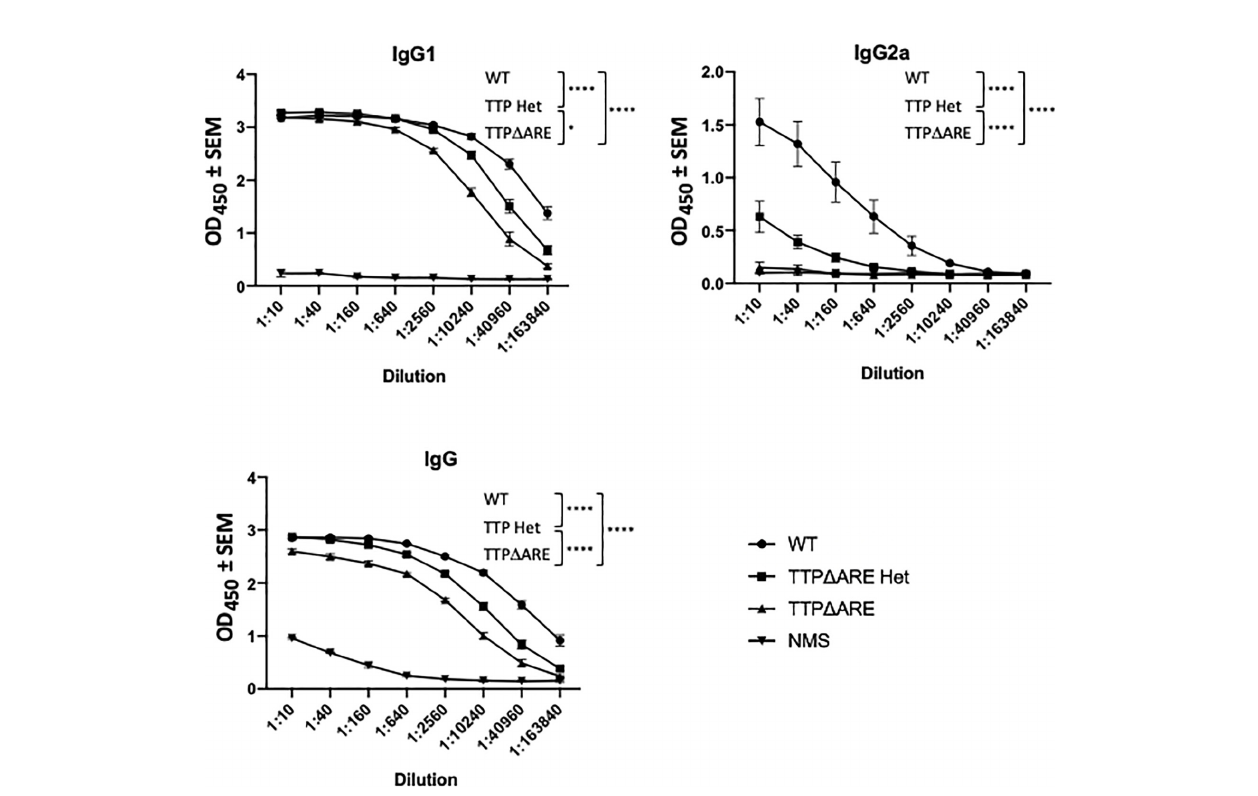
FIGURE 5 | Antibody production by cells of TTP D ARE homozygous and heterozygous mice and their WT controls. Sera from mice of the three groups were analyzed for anti-interphotoreceptor retinoid-binding protein (IRBP) antibodies by ELISA. The antibody isotypes were determined using the appropriate antibodies for hybridization. Shown are the combined data from eight individual homozygous TTP D ARE mice, 10 heterozygous mice, and 10 WT controls. Sera were collected from the same mice whose cytokine responses are quantitated in Figure 4 . Two-way ANOVA with Tukey ’ s post hoc test was performed for statistical comparisons between groups. *p < 0.05; ****p < 0.0001. NMS, normal mouse serum, collected from naïve C57BL/6 mice, was used as negative control.